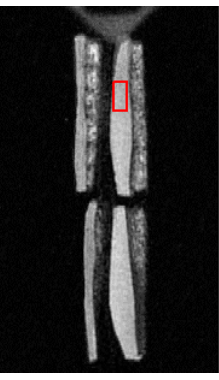
Figure 3. A representative UTE MR image of four patellar cartilage sections to indicate one Region of Interest (ROI). The red rectangle indicates one sample of the ROIs to acquire values of the UTE MR images.